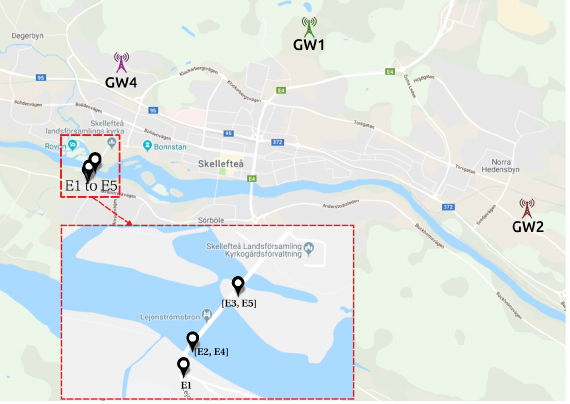
Figure 3. S1—gateways and sensors positioning. Map layer from Google Maps